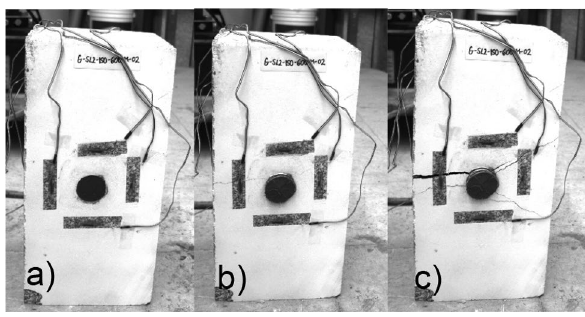
Fig. 14 G-SL2-150-600-M-02 a At time t Complete breakage at t 13